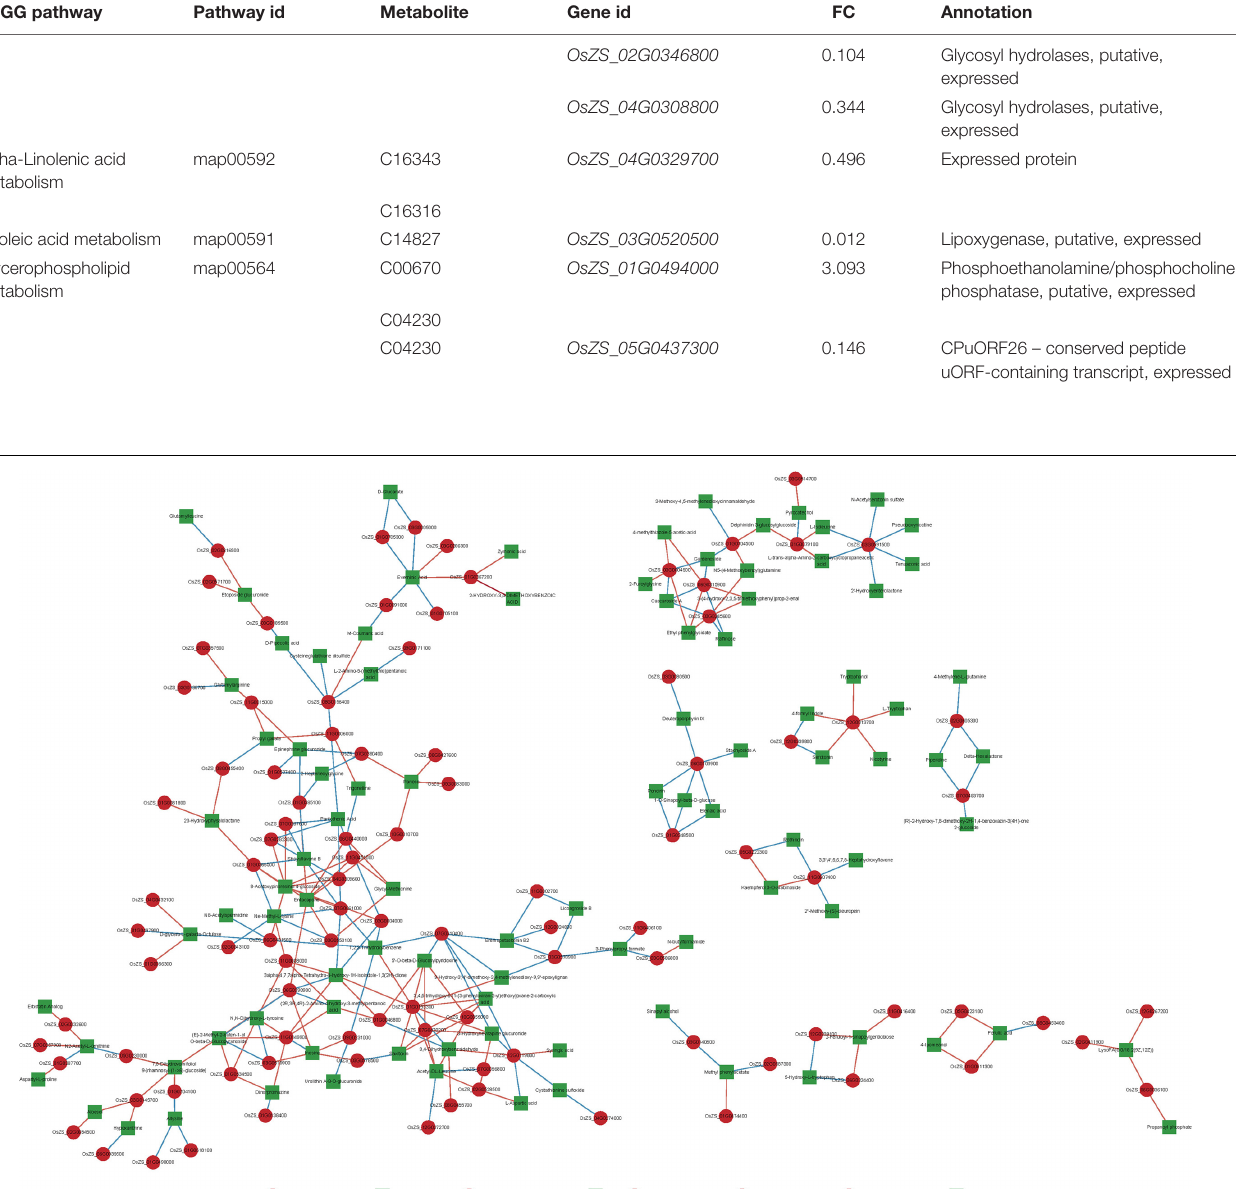
Frontiers in Plant Science |